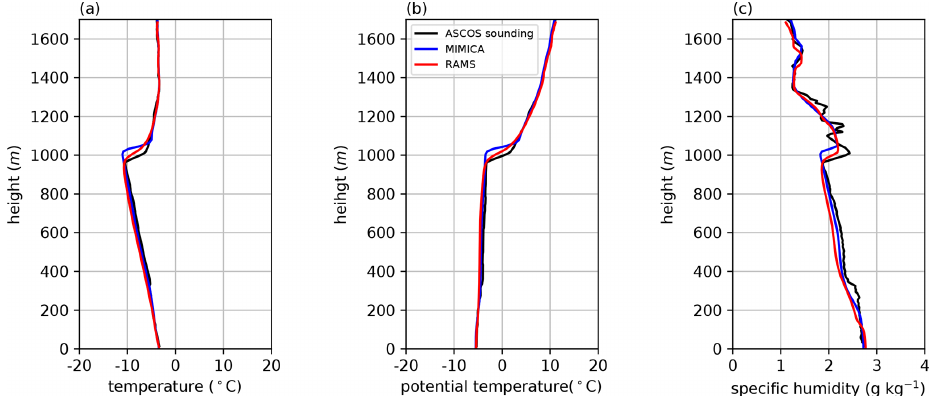
Figure 1. Radiosonde observations from 05:35UTC on 31 August 2008 of (a) absolute temperature, (b) potential temperature and (c) specific humidity. The corresponding simulated profiles from MIMICA and RAMS are presented for the middle of the simulation period (6h of simulation